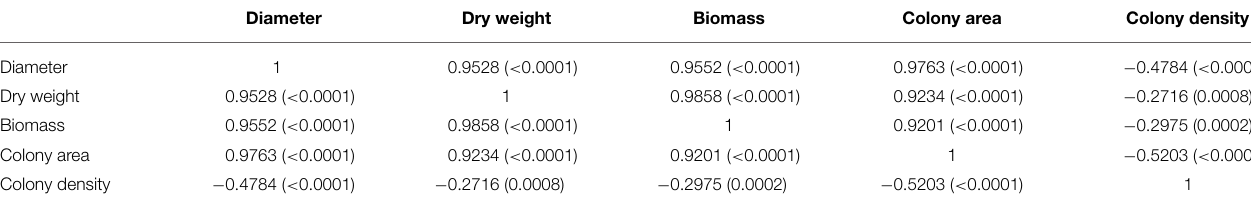
TABLE 1 | Correlation among growth responses (Pearson coefficients and corresponding P -values in parentheses). Diameter Dry weight Biomass Colony area Colony density